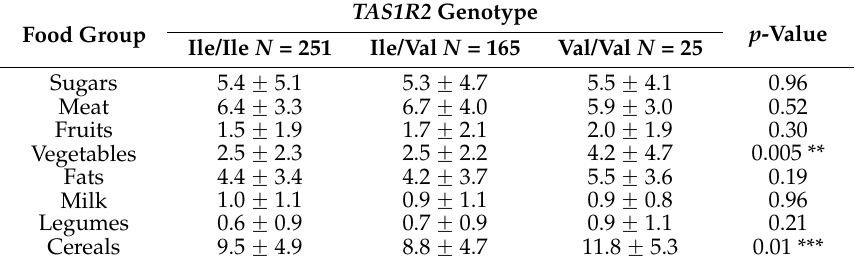
Table 3. Average daily intakes of food group servings by TAS1R2 genotype.